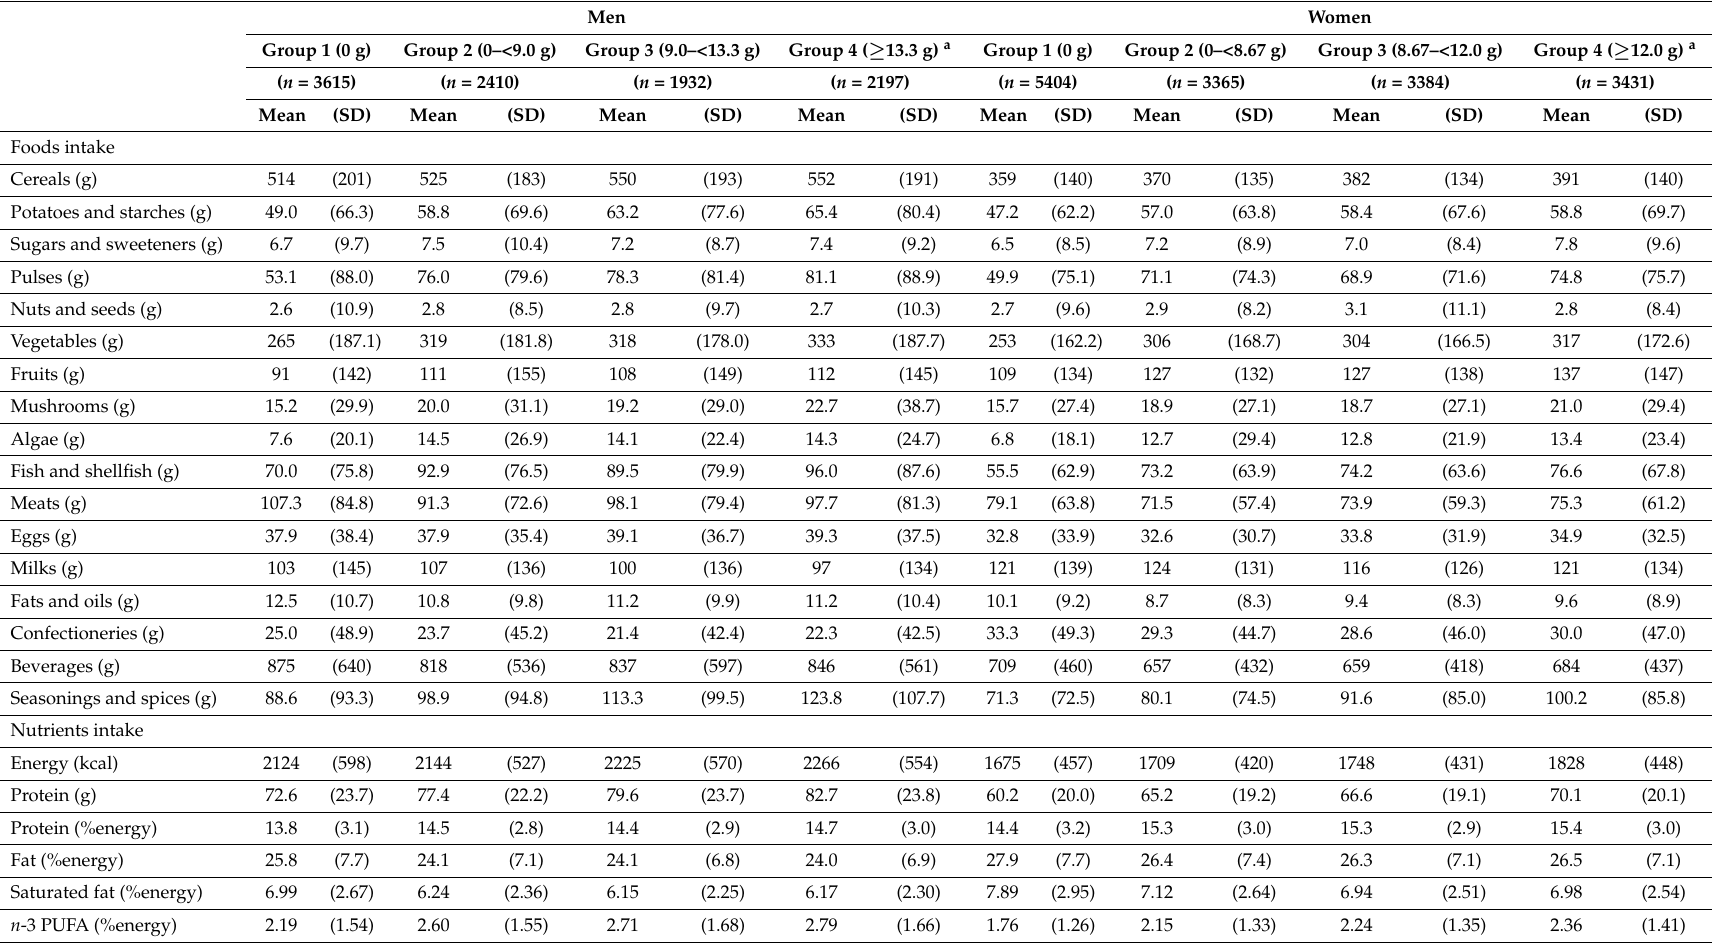
Table 4. Characteristics of the dietary intakes of the participants according to the portion size of